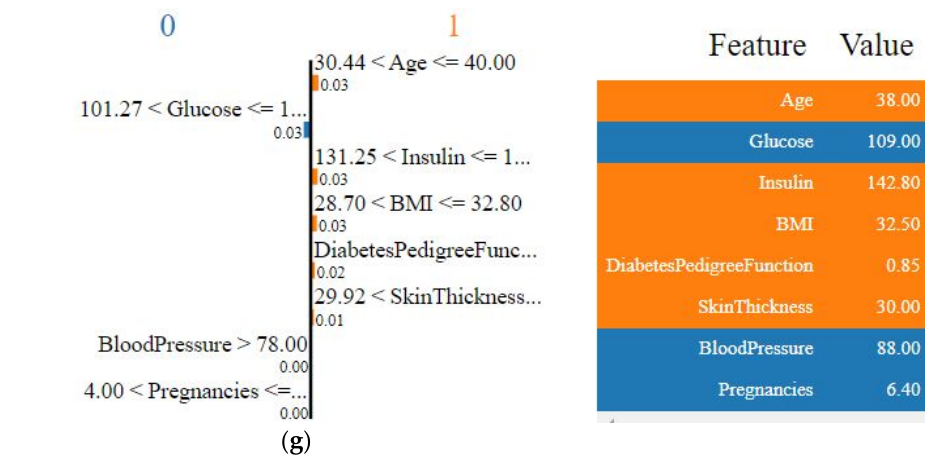
Figure 6. LIME tabular explainer of ( a ) ANN, ( b ) SVM, ( c ) LR, ( d ) RF, ( e ) ADA, ( f ) XGB, and ( g ) Voting classifier. Table 7. Values (Natural unit) of every feature of a selected test sample corresponding to Figure 6. Features Values (Natural Unit)